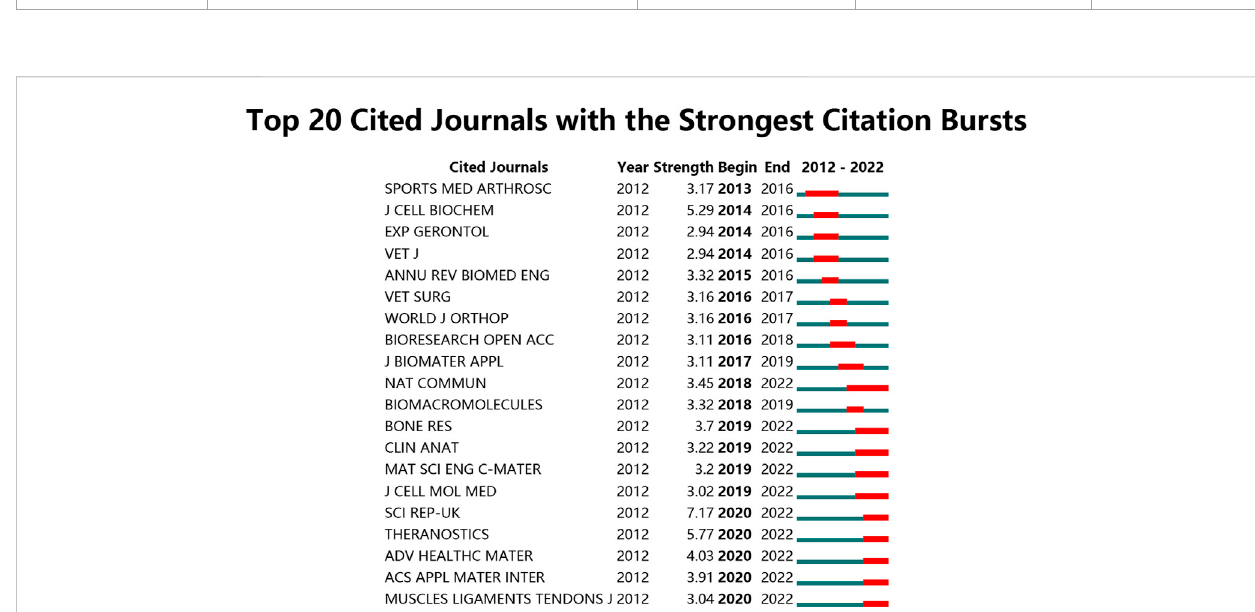
FIGURE 9 Top 20 cited journals with the strongest citation bursts of publications related to stem cells for meniscal